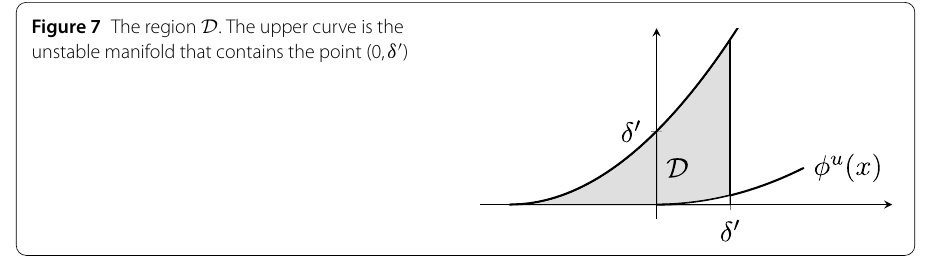
curve through (0, δ (cid:10) ) intersects any vertical line x = x 0 with 0 < x 0 ≤ δ (cid:10) . Let D be the open region bounded by the unstable invariant curve, the vertical line x = δ (cid:10) , φ u , and the x